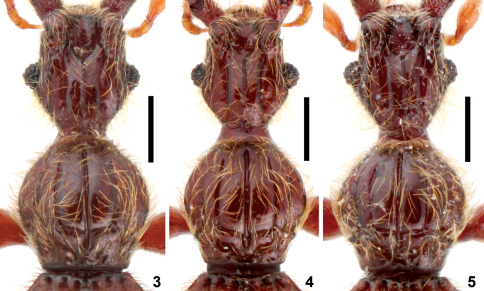
Head and pronotum of Intestinariusspp., male. 3 Intestinarius guangdongensis4 Intestinarius kuzmini 5 Intestinarius  longiceps. Scales: 0.3 mm.